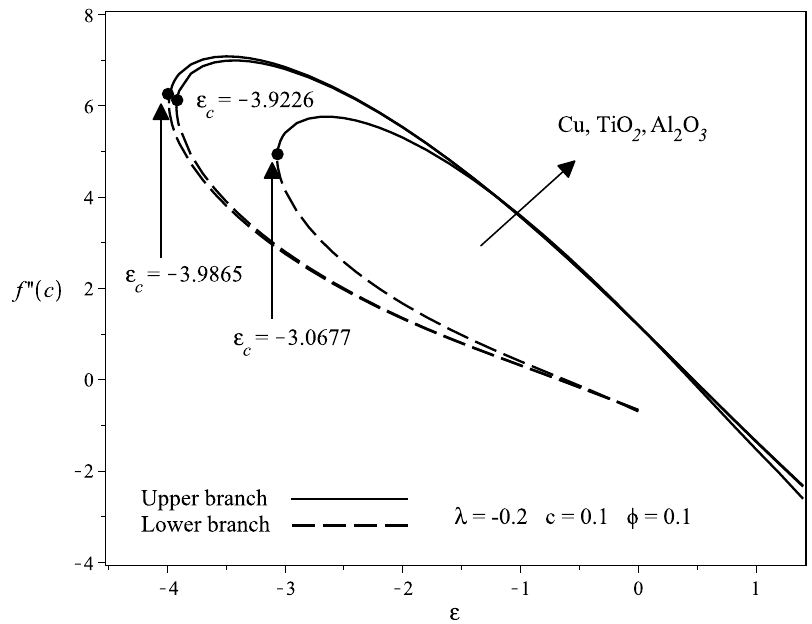
Figure 4. Effect of the velocity ratio parameter ε on the variation of shear stress for different